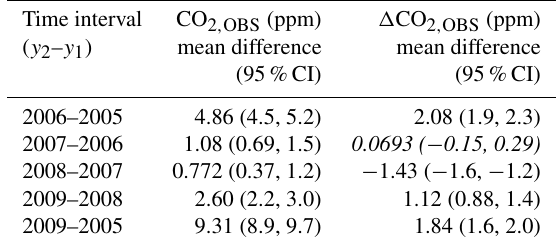
Table 3. Inter-annual observed CO 2 and (cid:49) CO 2 differences. Dif- ferences are of observations between consecutive years. The 95% confidence intervals are derived from a two-sample t test. Italicized entries denote instances where the inter-annual difference is not sta- tistically significant (confidence interval includes